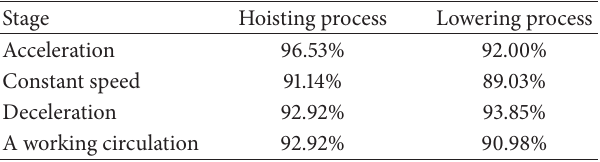
Table 2: Equivalent static efficiency of the gear